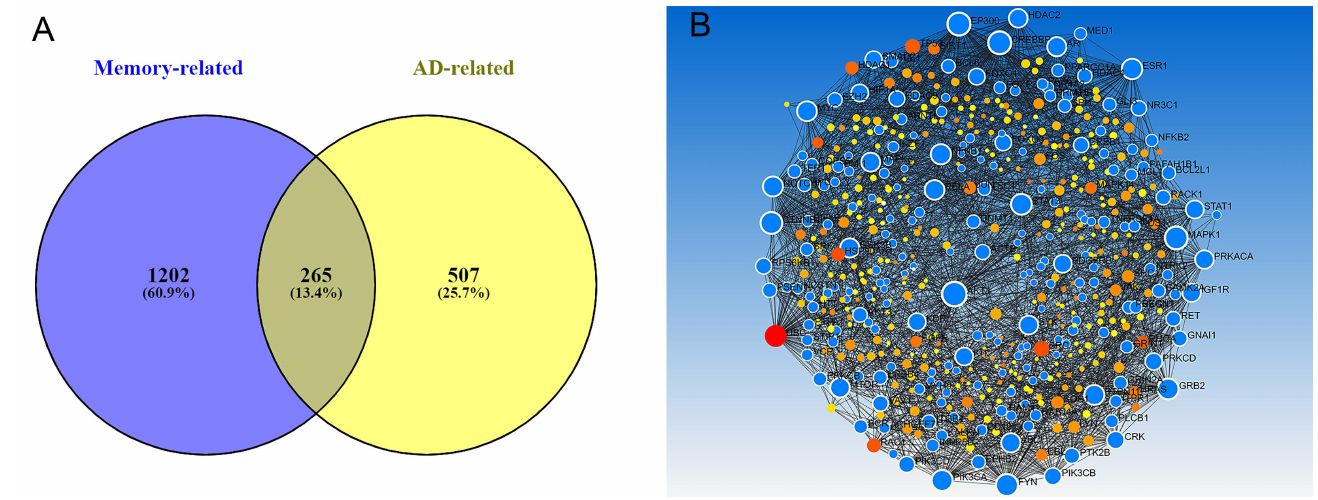
Figure 2. ( A ) Venn diagram representing the intersection between the memory related genes from various neurodegenerative disorders and the general Alzheimer’s Disease genes. Thei cross-section is called the Memory in Alzheimer’s Disease gene set (MADgs). ( B ) Protein–Protein Interaction network produced by the MADgs (blue nodes = MADgs genes).